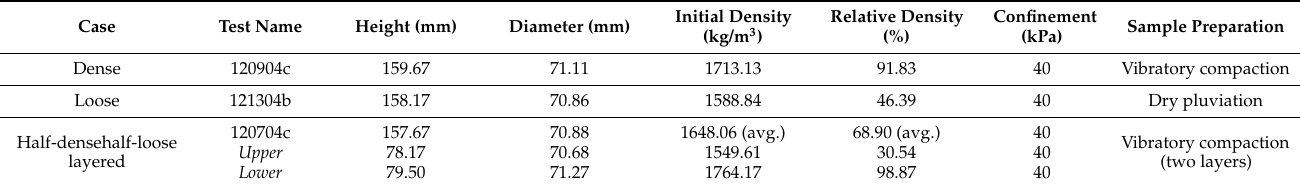
Table 1. Summary of experimental tests used in this study [1].